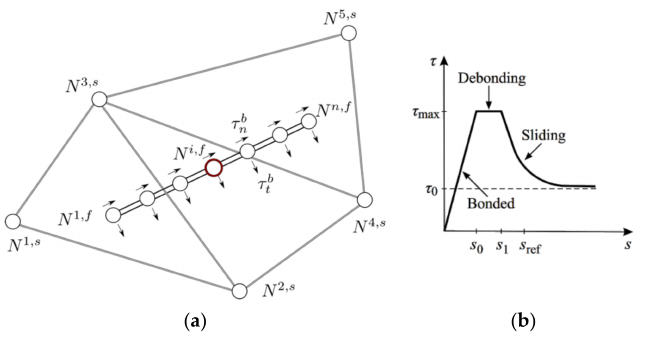
Figure 7. ( a ) Discretely modeled fiber using multiple Bernoulli beam elements. Each node i (marked with a red circle) of the fiber element f is tied to the corresponding solid element s through the bond element b . Bond elements provide resistance to axial sliding and lateral motion of fibers embedded in the solid matrix. ( b ) Illustration of three stages of the bond-slip law and meaning of bond parameters.